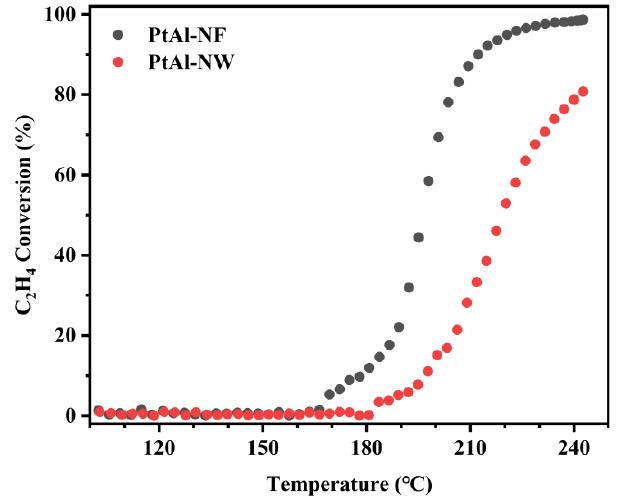
Figure 4. C 2 H 4 combustion over a series of Pt (1 wt.%) catalysts at temperatures from 100 to 250 °C; Reaction conditions: 700 ppm C 2 H 4 , 10% O 2 , N 2 balance, and GHSV = 600,000 mL g cat. −1 h – 1 .